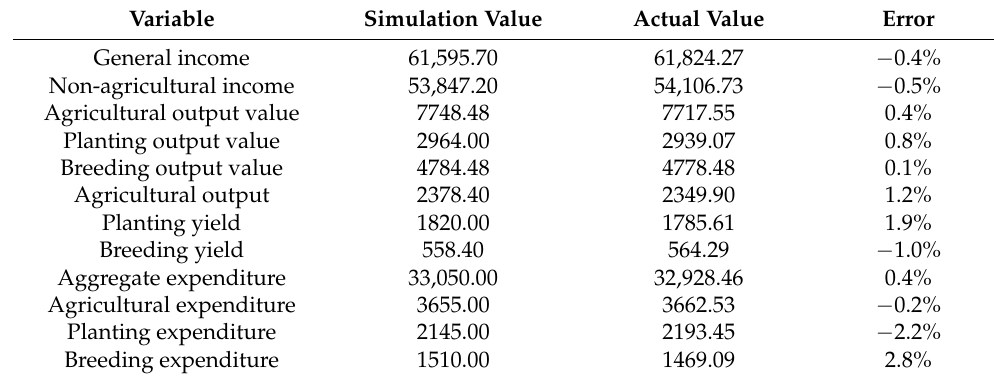
Table 4. Historical test results of some